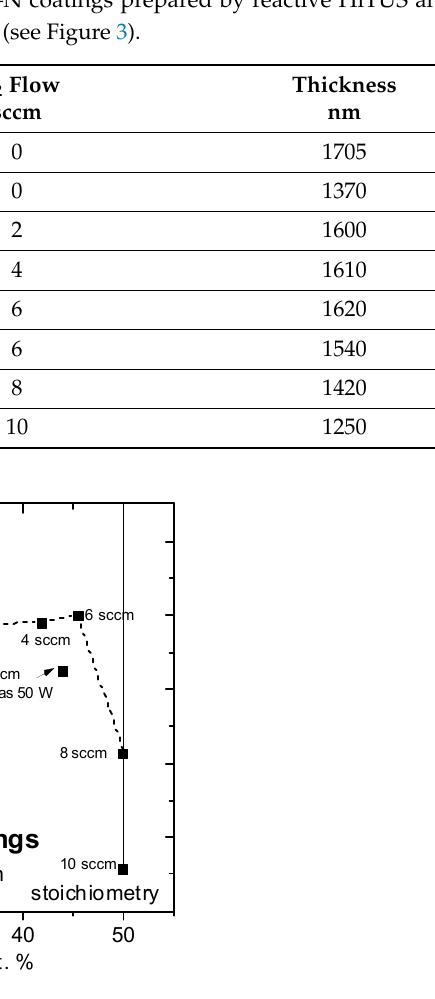
Figure 2. The average deposition rates of the studied HiTUS TiNbVTaZrHf-xN coatings at different nitrogen flows as a function of nitrogen atomic concentrations (nitrogen concentrations were taken from later IBA measurements).